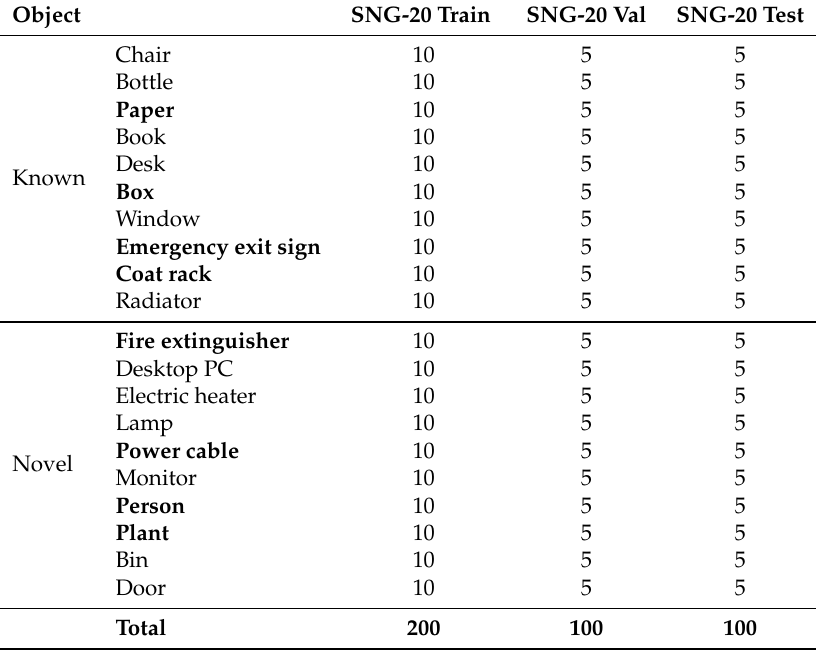
Table 2. 20-Class Datasets Statistics. Novel classes with respect to the ImageNet-1000 dataset are